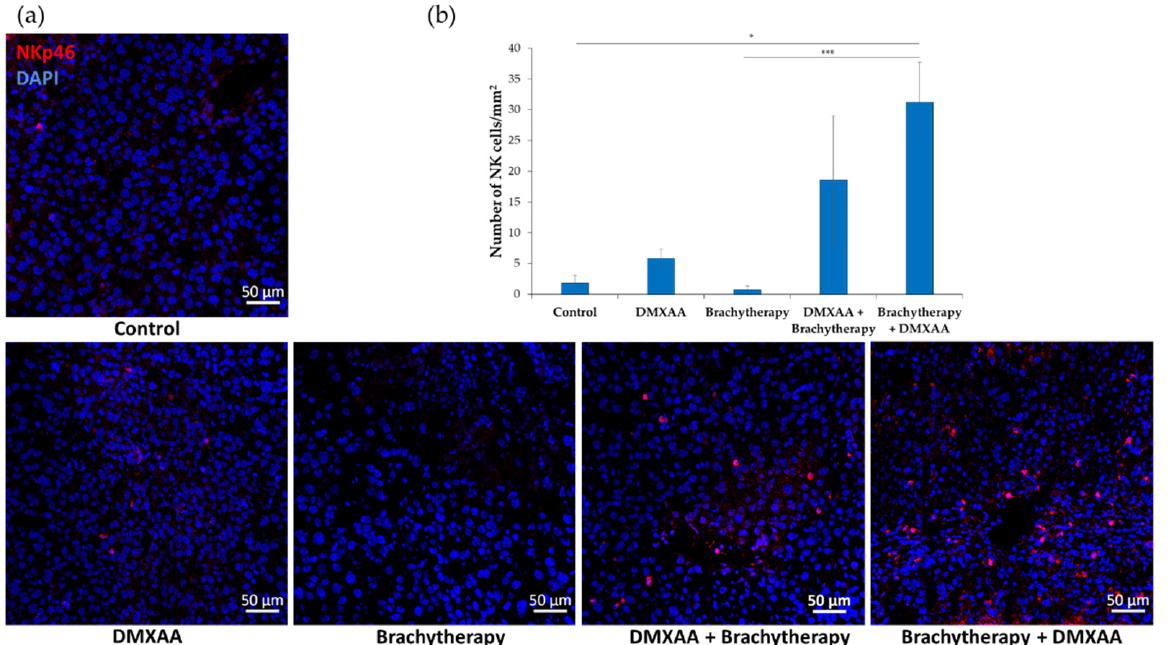
Figure 6. Effect of combination therapy on infiltration of tumors by NK cells. Twenty days after tumor inoculation tumors were collected. ( a ) Tumor sections were stained with anti-NKp46 antibody. NKp46 positive NK cells (Alexa Fluor 594, red) and nuclei (DAPI, blue) were visualized using confocal microscope. Photograph were taken in 5 randomly chosen fields (magn. 20 × ) per section in at least 3 tumors of each group. Representative photographs are shown. ( b ) Total number of NKp46 positive cells was calculated per mm 2 of tumor section (mean ± SEM) * p < 0.05 *** p < 0.001 Kruskal–Wallis multiple